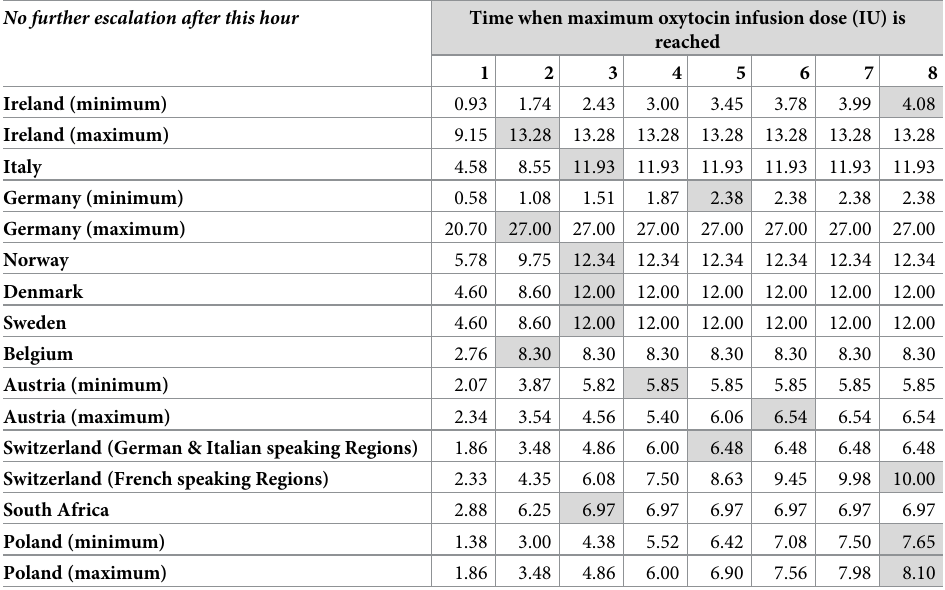
Table 10. Time when maximum oxytocin infusion dose would be reached with maximum escalation. No further escalation after this hour Time when maximum oxytocin infusion dose (IU) is